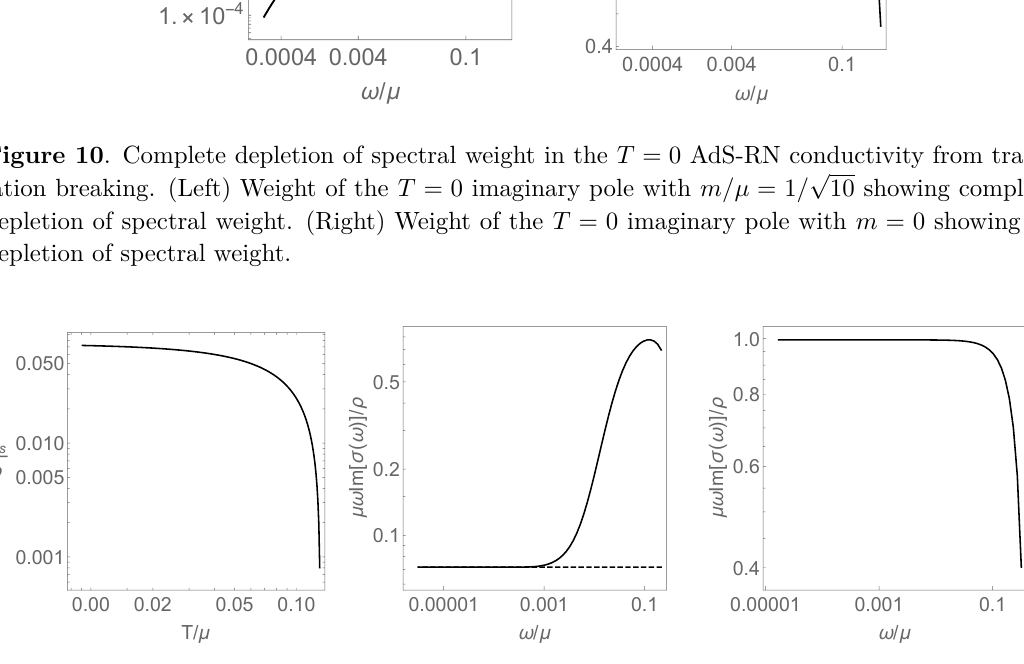
Figure 11 . The normal density for a = 4 semi-local quantum critical superfluids. (Left) Finite temperature ρ n from equation (3.16). (Center) Weight of the T = 0 imaginary pole with m/µ = . 315 showing partial depletion of spectral weight and ρ (0) n = ρ (0) − ρ (0) s 6 = 0 . The dashed line is the value we find as T → 0 from equation (3.16). (Right) Weight of the T = 0 imaginary pole with m = 0 showing no depletion of spectral